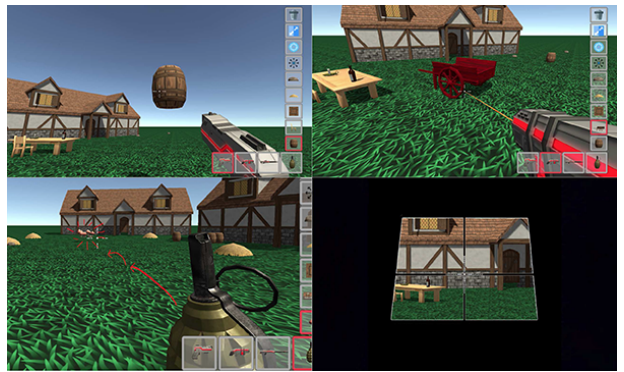
Figure 8. Overview of the implemented guns (clockwise): pistol, laser, sniper, grenade.